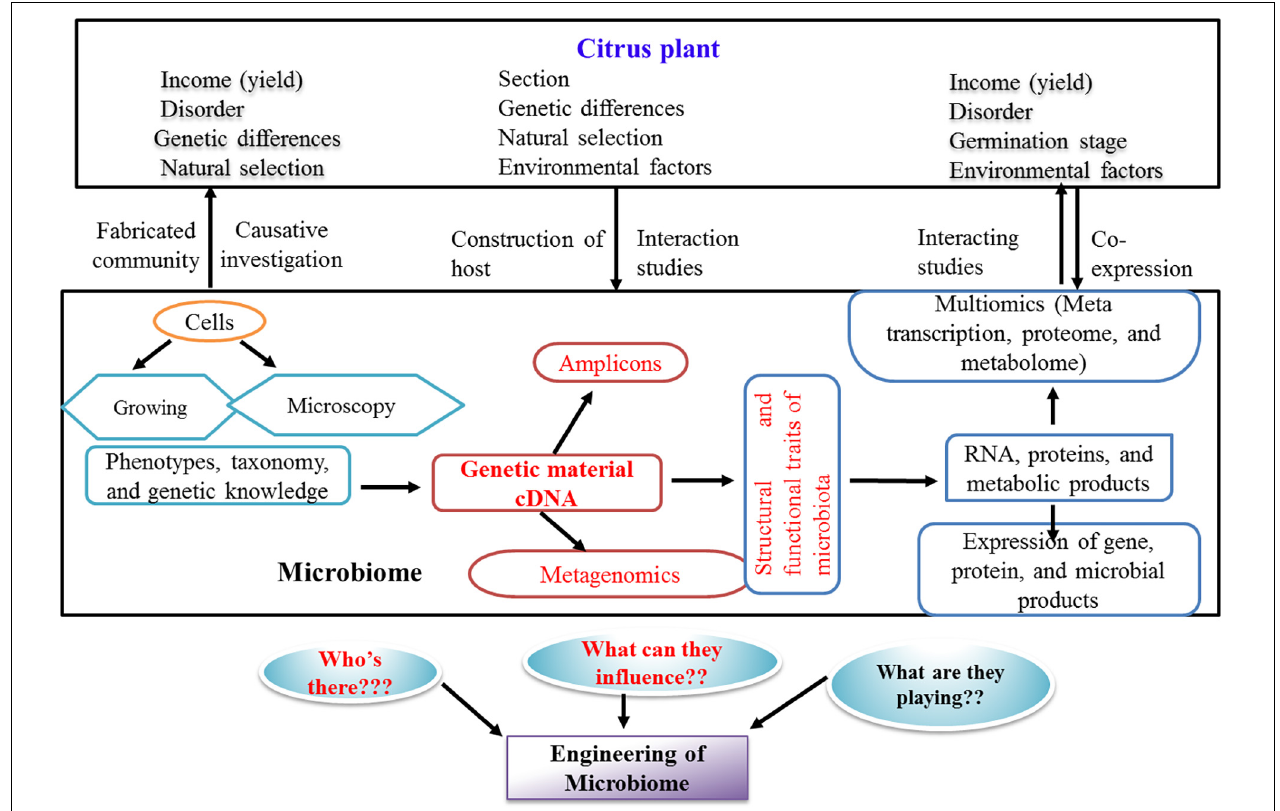
FIGURE 2 | Prospective methods and questions for the research of citrus microbiome in current scenario. The present state of investigation about the citrus microbiome is highlighted in red